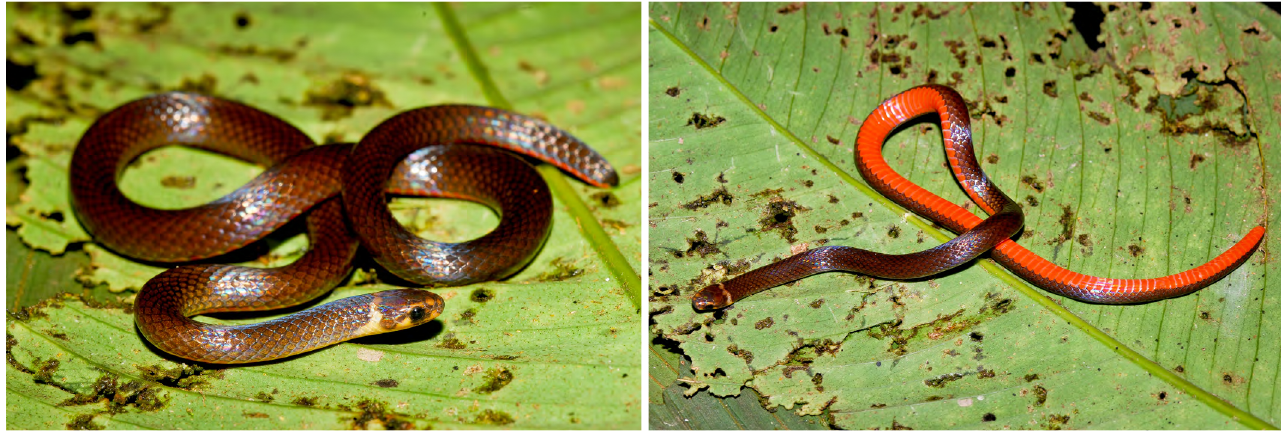
Figure 1. Collected specimen of Tantilla alticola from Valle del Cauca department,